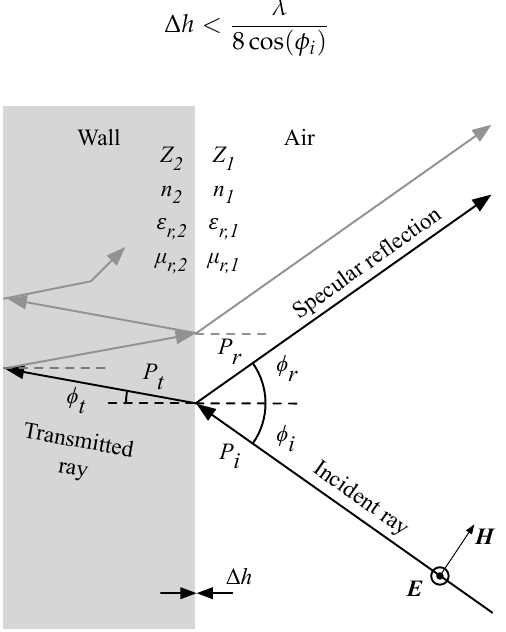
Figure 4. Multipath effect at a smooth and large material